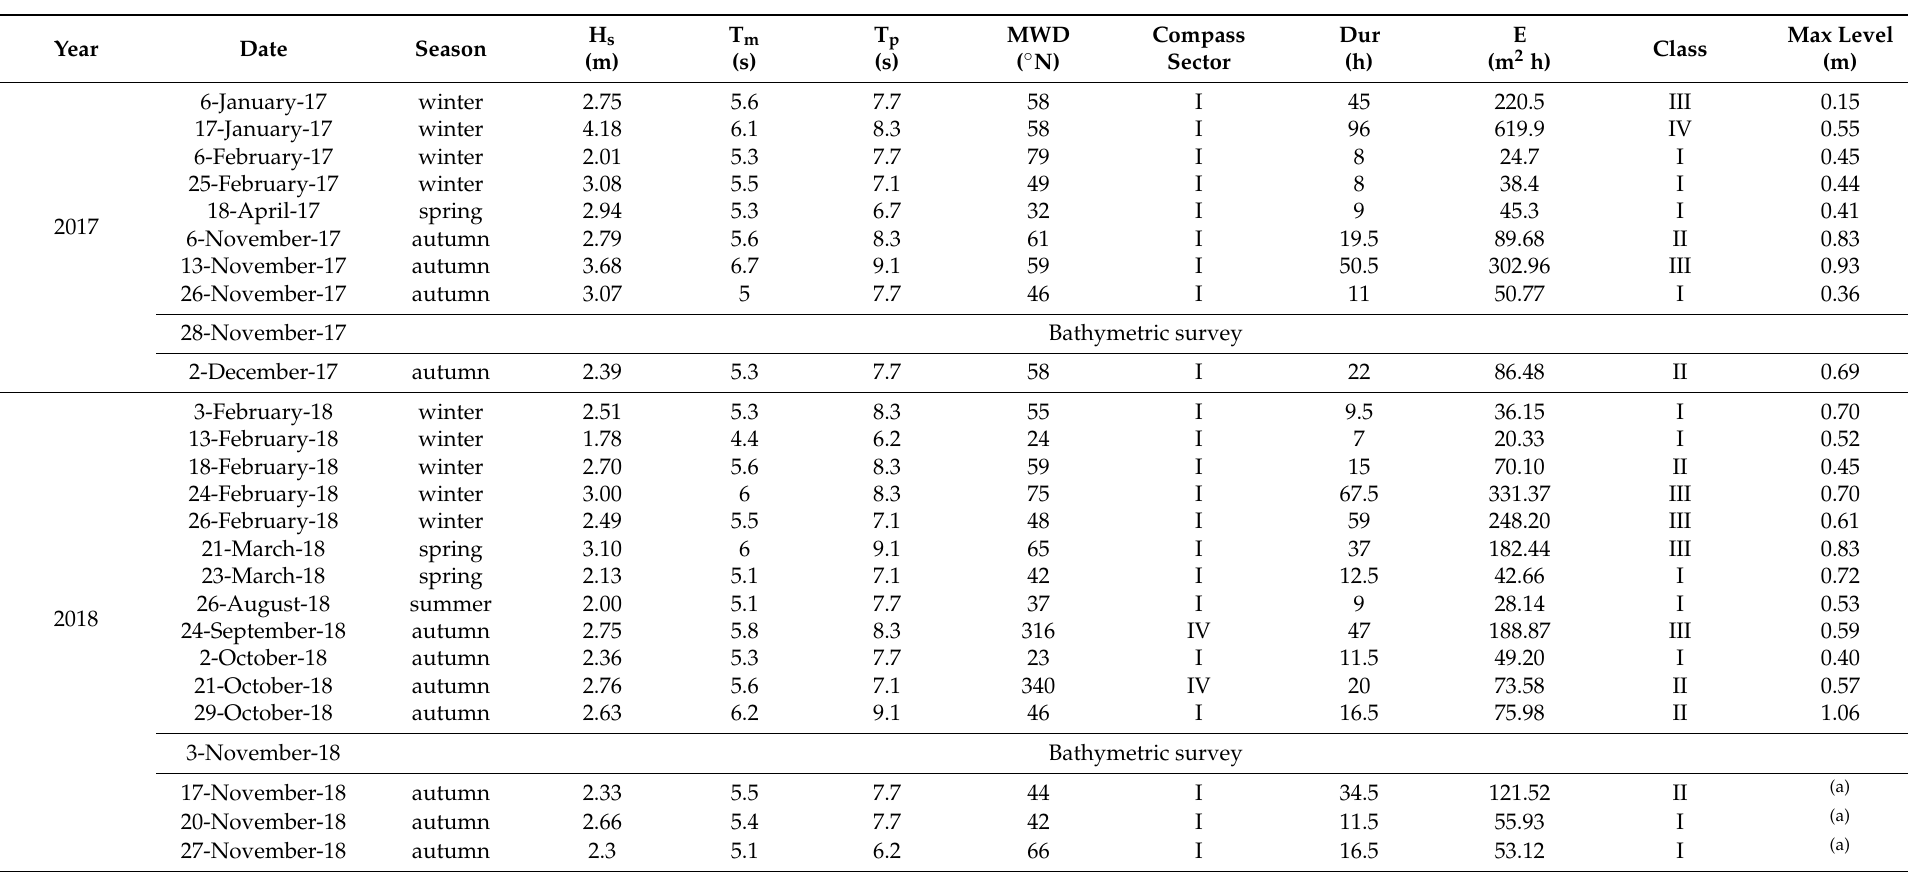
Table A2. Sea storm events occurring in the period 2017–2021: wave significant height (H s ), mean (T m ) and peak (T p ) wave period, mean wave direction (MWD), compass sector, storm duration (dur), storm energy (E), energetic class, max sea level at Ravenna or Porto Garibaldi (in gray). (a) Sea level data not available at Ravenna or Porto Garibaldi; (b) Nausicaa data not available. The timing of the bathymetry surveys performed in the studied area is also